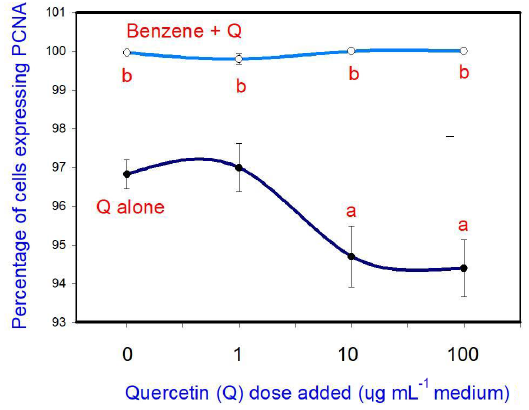
Figure 1. Effects of benzene, quercetin extract, and their combi- nation on cell proliferation in cultured porcine ovarian granulosa cells. Parts marked “a” show the effect of quercetin extract (sig- nificant difference ( P< 0 . 05) between cells cultured without and with quercetin addition at three different levels without benzene), b the effect of benzene (significant difference, P< 0 . 05) between cells cultured with or without benzene for each quercetin dose sep- arately), and c the effect of quercetin extract with simultaneous benzene presence (significant difference ( P< 0 . 05) between a cell cultured with and without quercetin addition at three different lev- els with simultaneous benzene addition); effect of benzene alone (20µgmL − 1 ) is displayed for quercetin dose at 0µgmL − 1 .